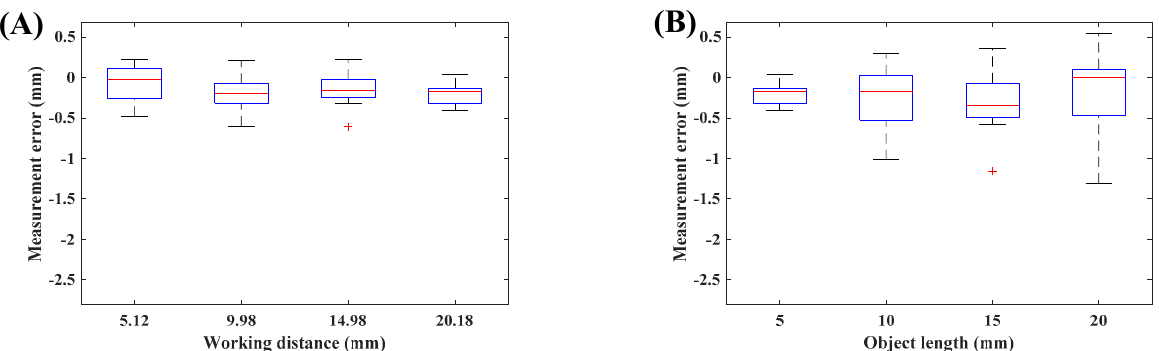
Figure 13. Performance of non-uniform model for general measurements: ( A ) effect of working distance, ( B ) effect of object length.